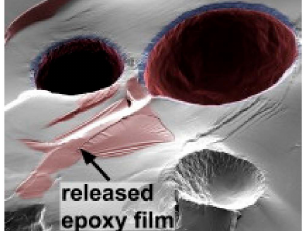
Figure 2. Image of ruptured urea–formaldehyde (UF) microcapsules having both reactive epoxy resin and solvent as the core material. The regions of deposited epoxy film are indicated. Adapted from [12], with permission from © 2009